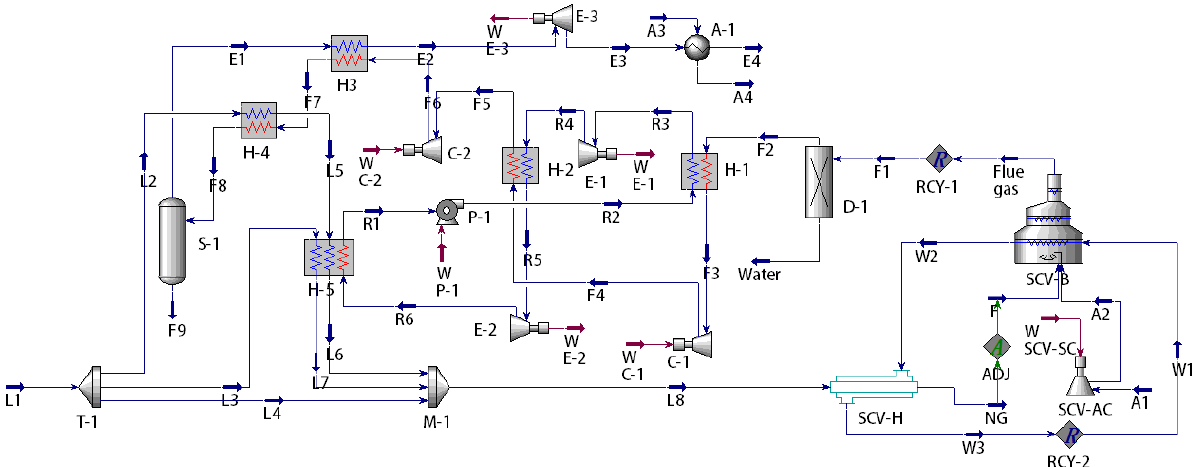
Figure 1. System A: HYSYS simulation model of SCV flue gas carbon capture using LNG cold energy. D-1: flue gas dehydrator; H-1–H-5: heat exchanger; C-1–C-2: compressor; E-1–E-3: turbine; P- 1: working fluid pump; M-1: mixer; A-1: air temperature heater; S-1: separator; T-1: tee; SCV-AC: